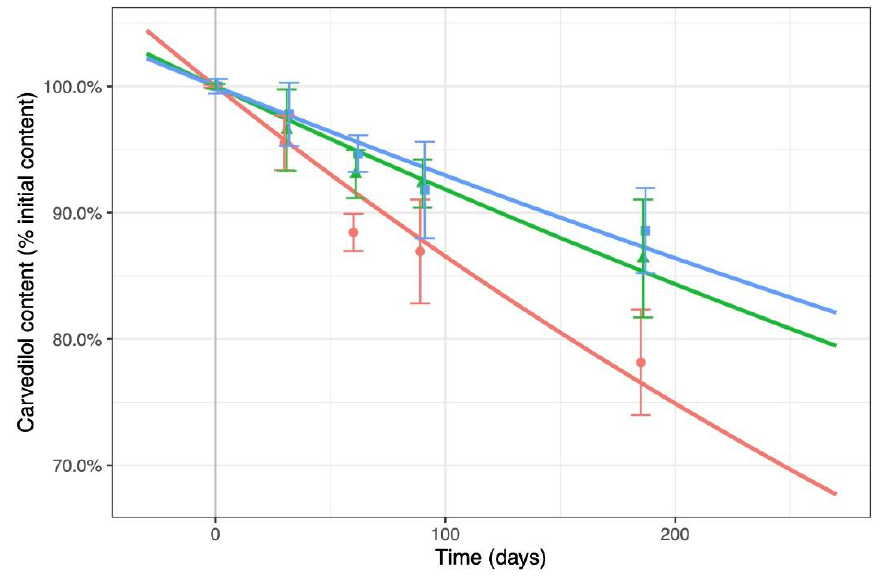
Figure 12. Mean and standard deviation (dots) values and single values (crosses) for the relative carvedilol content measured during photostability studies at 25 ± 2 °C) in aqueous acidic solutions (13 mM HCl) with acetonitrile/H 2 O (control, ), 61.5 mM γCD ( ) or 61.5 mM RAMEB ( ). The corresponding first-order kinetic model (solid line) is depicted on each plot. A small shift has been added to error bars to avoid their overlapping.